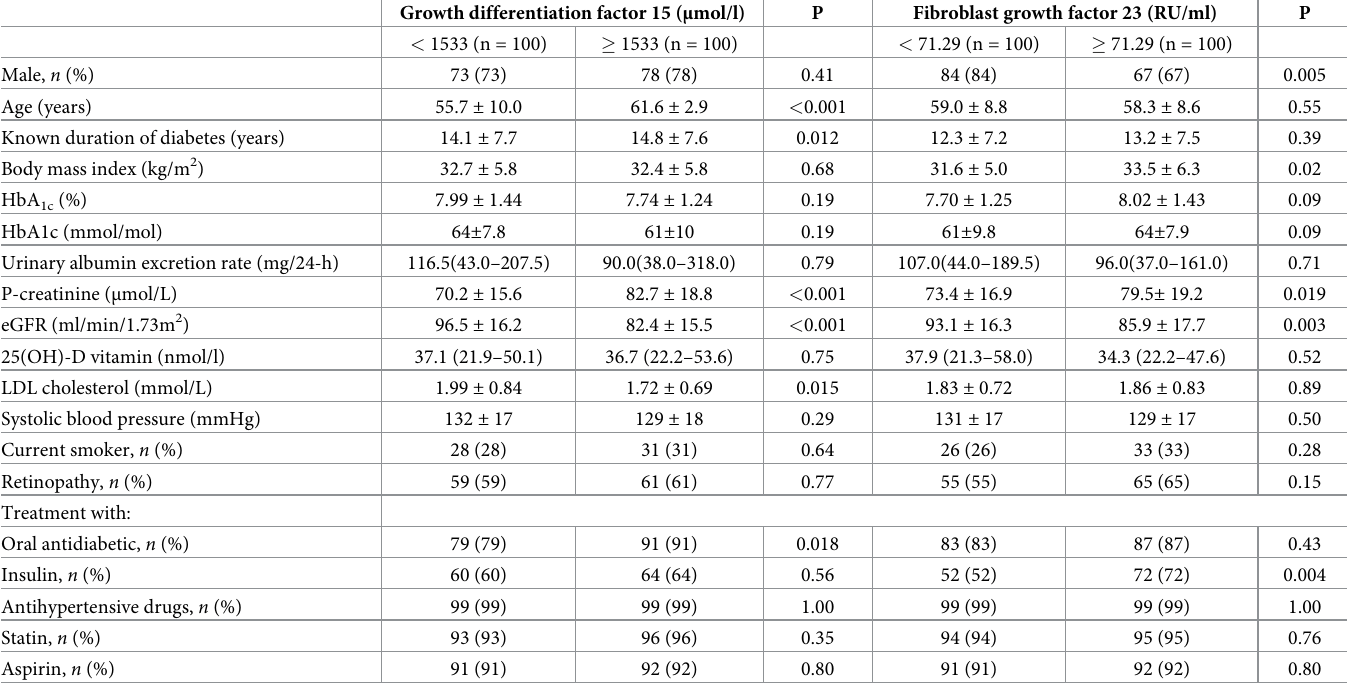
eGFR: estimated glomerular filtration rate. P-values for differences between participants with Growth differentiation factor 15, and Fibroblast growth factor 23 below or above the